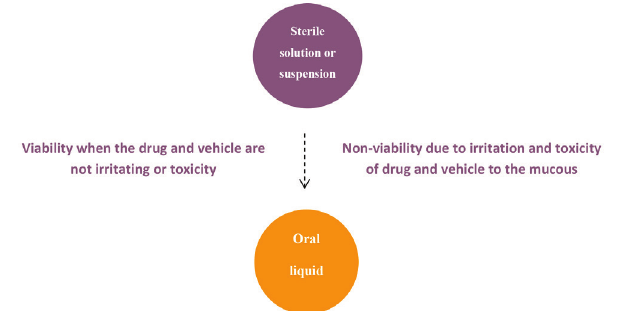
FIGURE 4 - Preparation of the oral liquid formulation from suspension or sterile